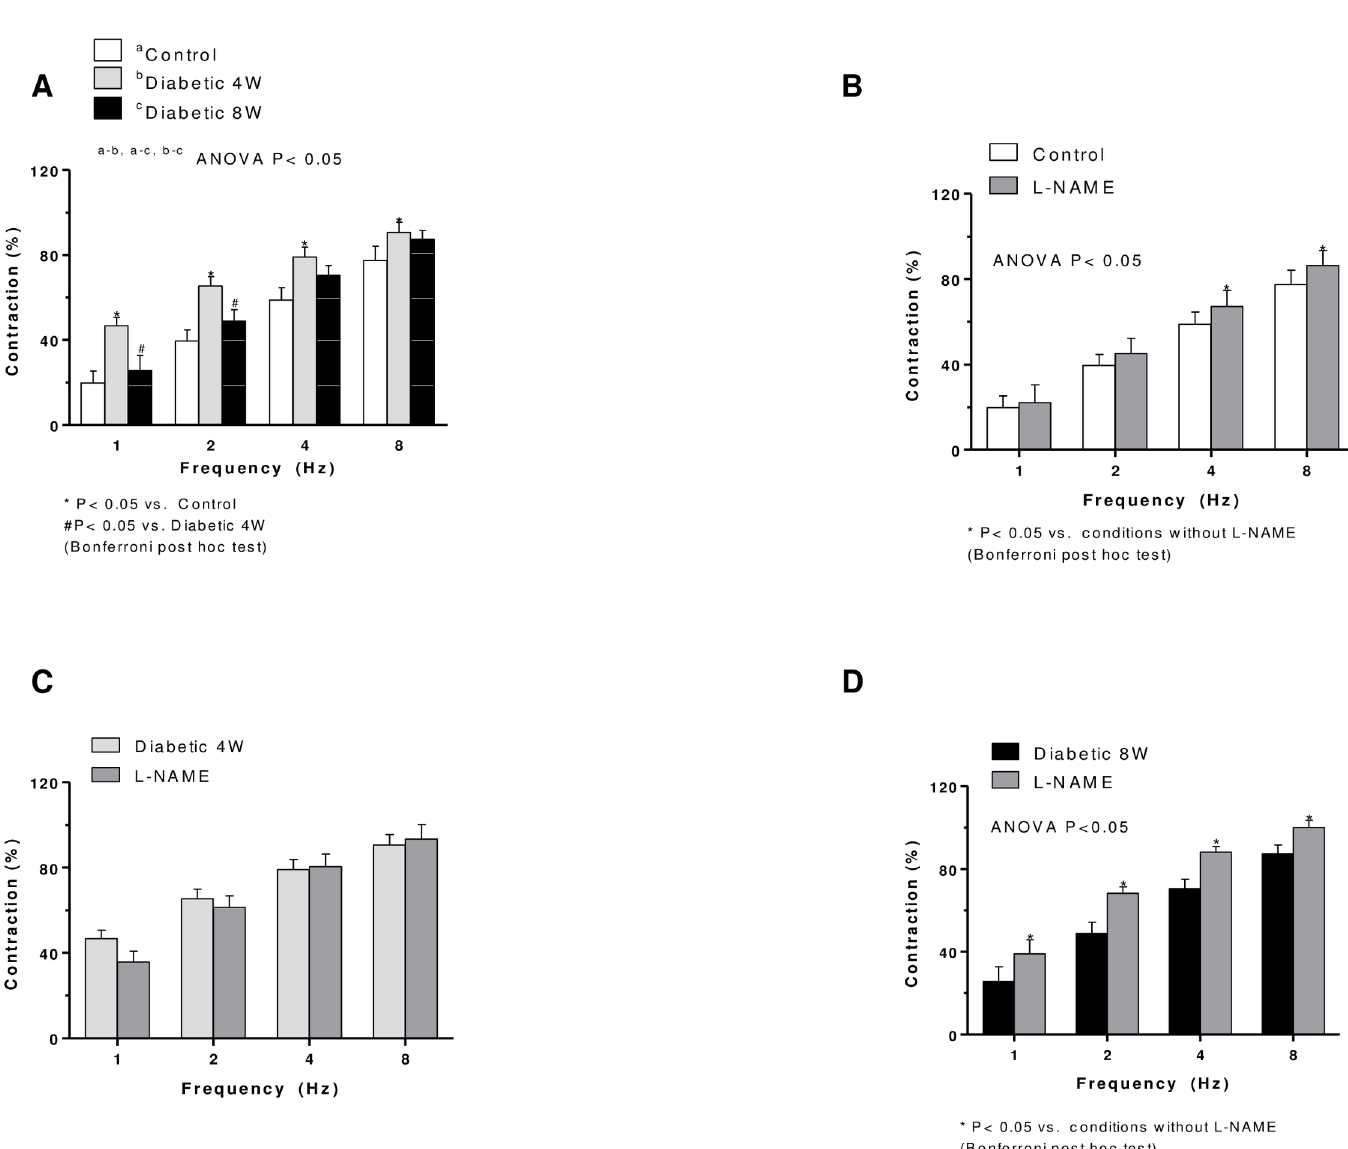
Fig 1. (A). EFS-induced vasoconstriction in endothelium-denuded mesenteric segments from four- (4W) and eight-week (8W) diabetic and non-diabetic rats. Effect of L-NAME on the vasoconstrictor responses induced by EFS in mesenteric segments from control (B), four- (C) and eight-week diabetic (D) rats. Results (mean ± SEM) are expressed as a percentage of the initial contraction elicited by KCl. N = 5 – 7 animals per